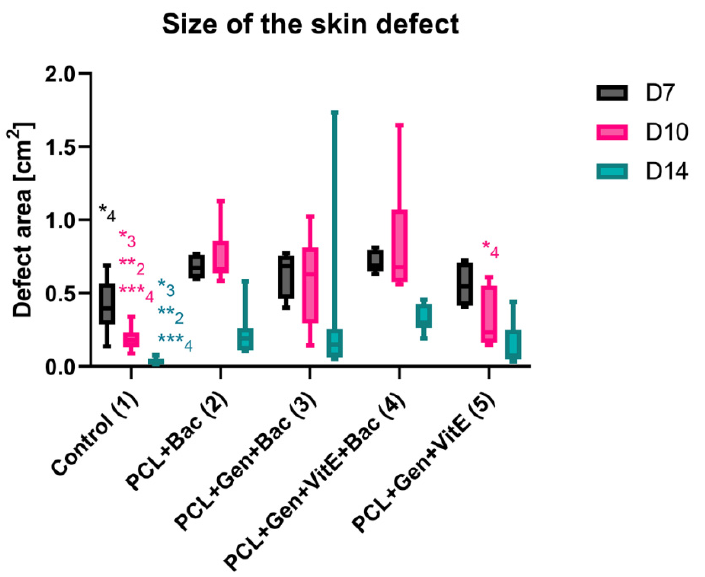
Figure 11. The size of the skin defects of mice treated with PCL nanofibers (PCL), gentamicin (Gen), α -tocopherol acetate (VitE), and infected by S. aureus and P. aeruginosa (Bac) or untreated defects (control) on days 7, 10, and 14 after surgery. The statistical significance was marked as a number representing the group. Significant difference * p < 0.05, ** p < 0.01, *** p < 0.001.